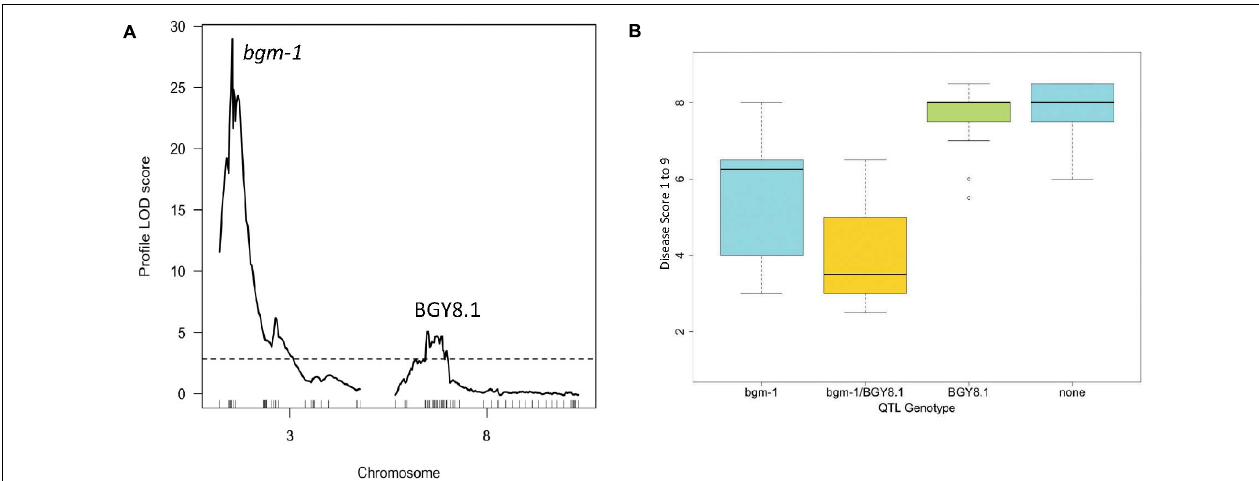
FIGURE 7 | Genetic mapping for resistance to BGYMV (1–9) evaluated in El Salvador in 2012 in DOR 476/SE. (DS) recombinant inbred population: (A) LOD profiles obtained by one-dimensional and two-dimensional genome scans. QTL models were fitted and refined using the multiple imputation method. Dashed line denotes significance at the 0.05 probability level and (B) interaction between bgm-1 and BGY8.1 for resistance to BGYMV.